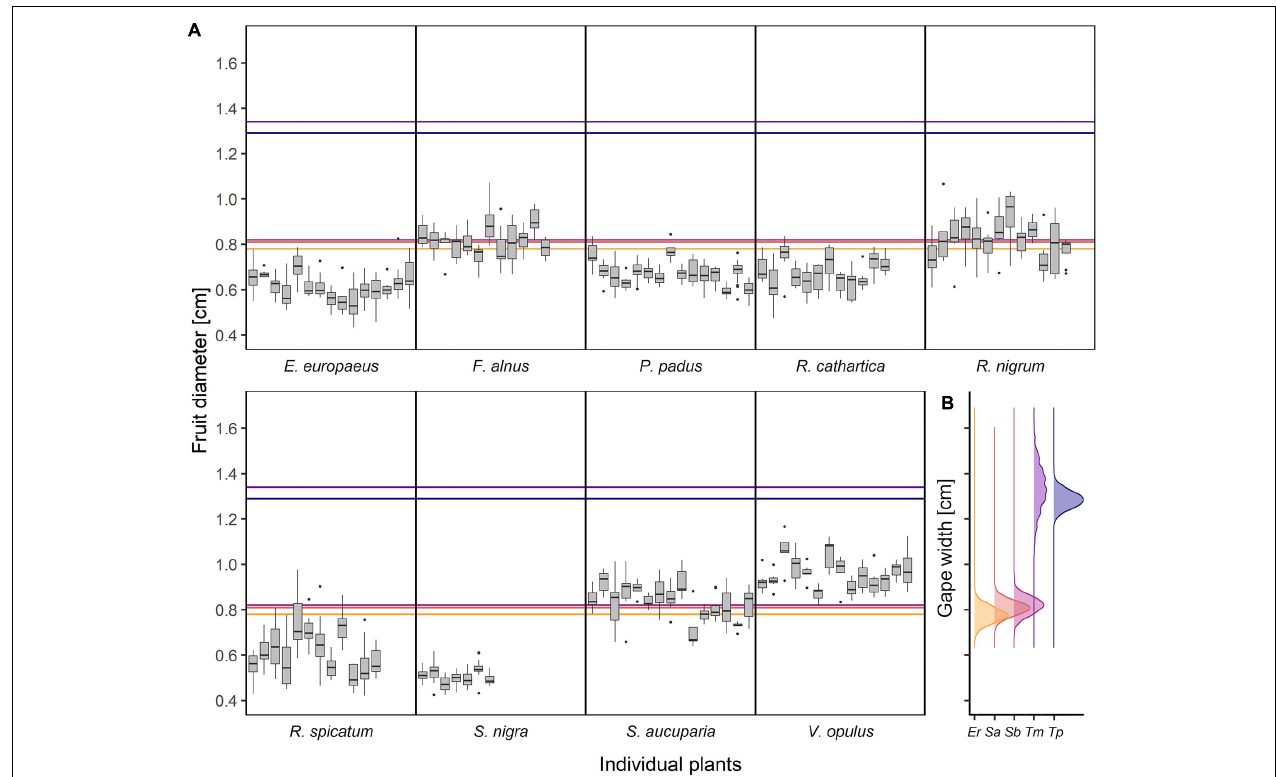
FIGURE 2 | (A) Boxplots showing sub- and interindividual variation in fruit diameter across nine fleshy-fruited plant species in Białowie˙za Forest, Poland. (B) Density plot of gape width of the five most important frugivore species (Er, Erithacus rubecula ; Sa, Sylvia atricapilla ; Sb, Sylvia borin ; Tm, Turdus merula ; Tp, Turdus philomelo s). Together with M. martes (gape width > 2 cm), these disperser species account for 97.0% of fruit removal interactions and 98.6% of the seed rain in the Białowie˙za Forest, Poland. The color of horizontal lines in (A) depict the mean gape width of disperser species in (B) , respectively.